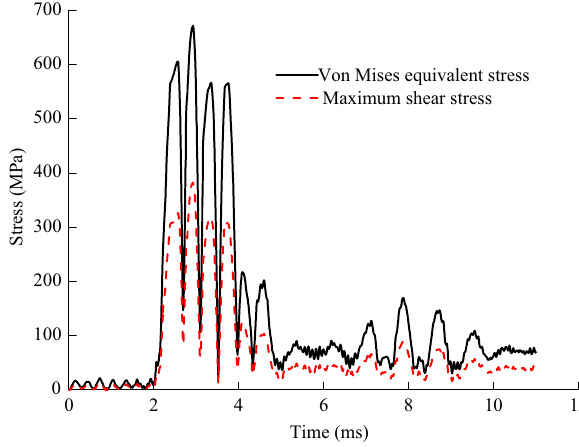
Fig. 3 Von Mises equivalent stress and maximum shear stress history